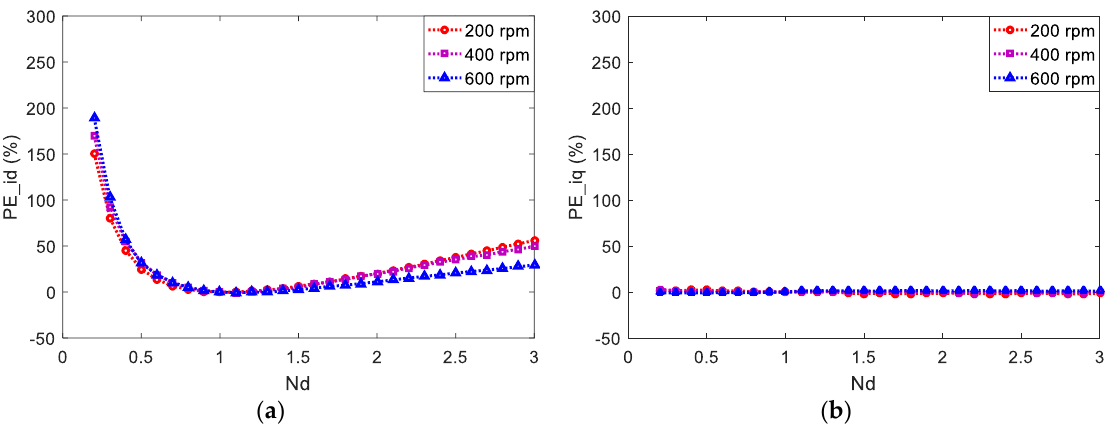
Figure 5. Relative prediction error under L d mismatch. ( a ) Relative prediction error of i d ; ( b ) Relative prediction error of i q .